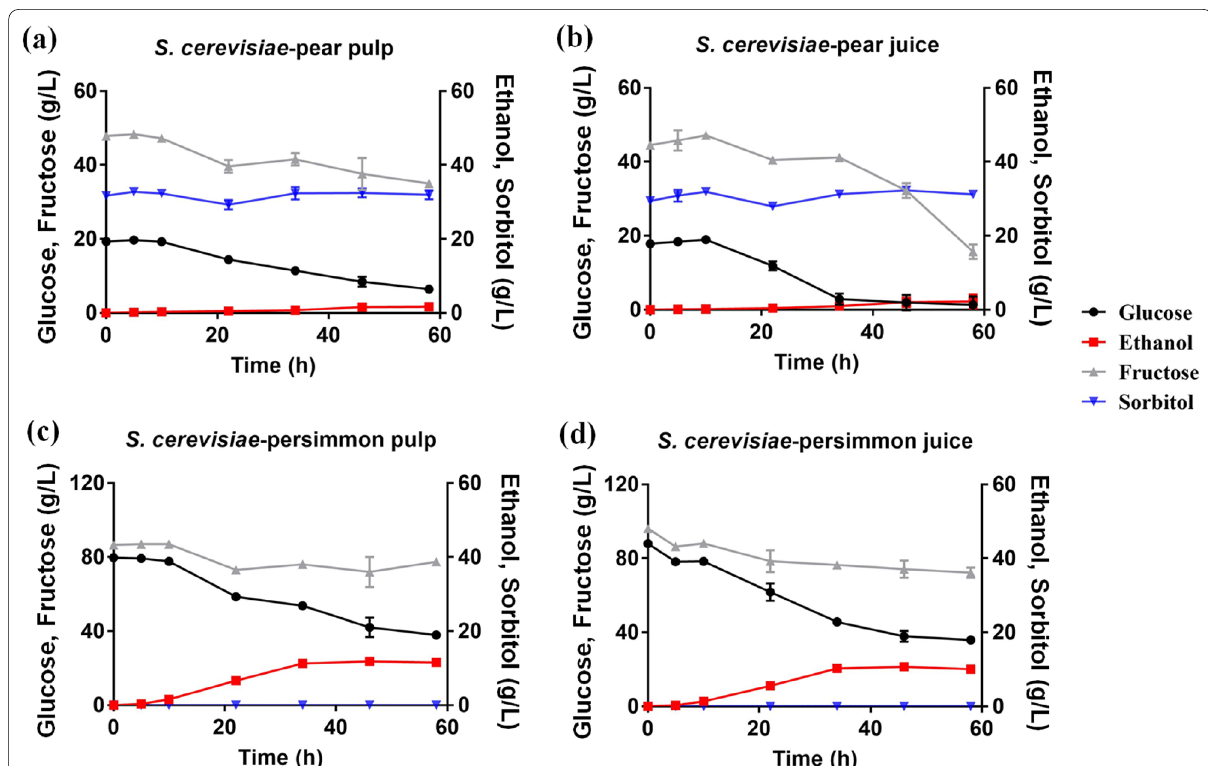
Fig. 3 Concentration changes of glucose (black circle), ethanol (red square), fructose (grey triangle), and sorbitol (blue inverted triangle) during fermentation by S. cerevisiae in pear pulp ( a ), pear juice ( b ), persimmon pulp ( c ), and persimmon juice ( d ), respectively. There were significant differences for glucose consumption ( p -value 0.02) and sorbitol production ( p -value 0.008) using pear pulp and pear juice = =